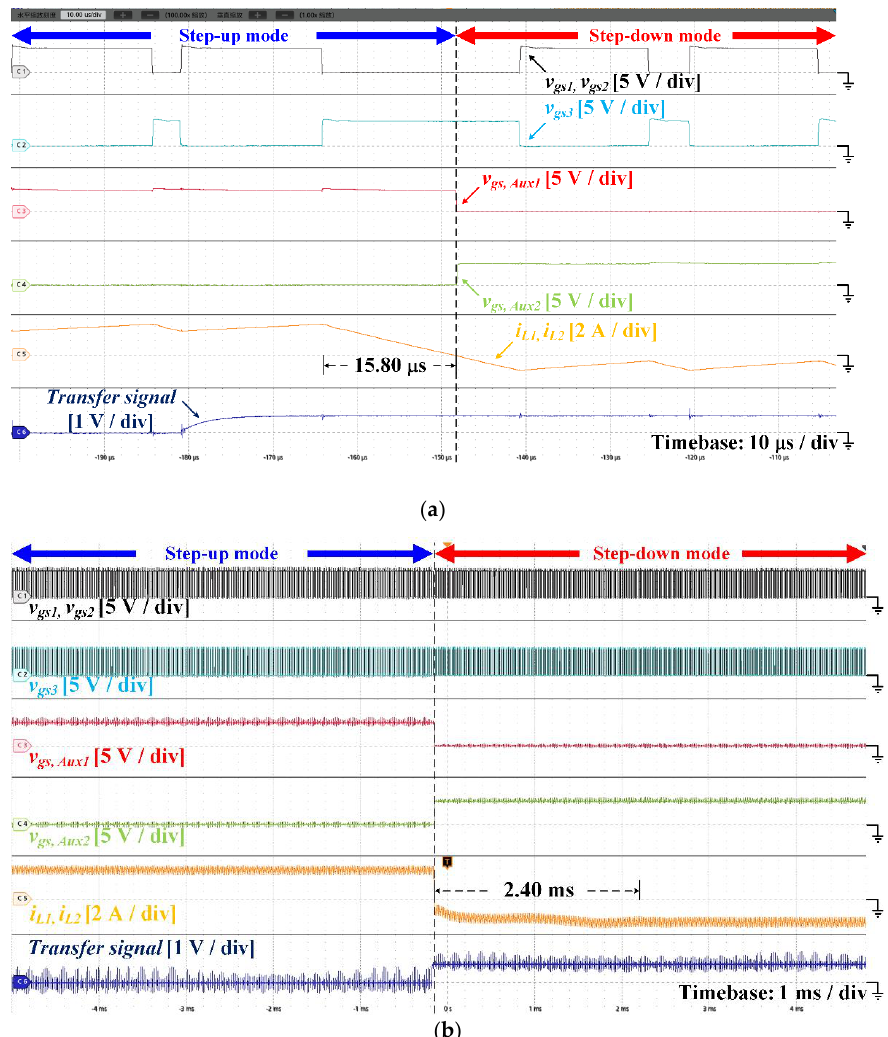
Figure 16. Waveforms of dynamic performances with 50% load condition. ( a ) v gs1 , v gs2 , v gs3 , v gs , Aux1 , v gs , Aux2 , i L1 , i L2 , transfer signal. ( b ) Change from the step-up mode to the step-down mode. v gs , Aux 2 , i L 1 , i L 2 , transfer signal. ( b ) Change from the step-up mode to the step-down